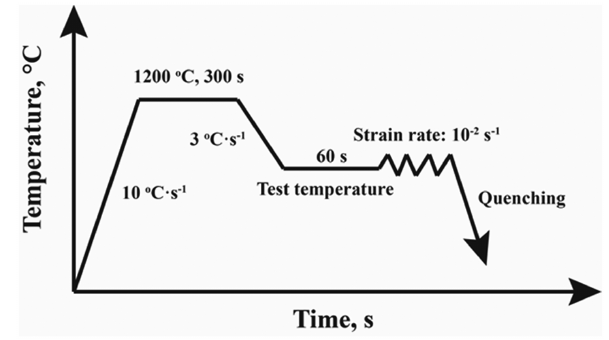
Figure 1: Thermal cycle of the hot ductility